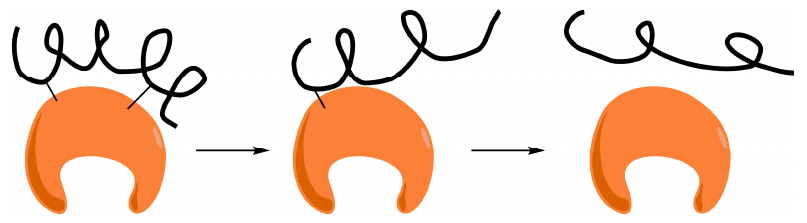
Figure 5. Schematic representation of the interaction process between two amino groups of non-vicinal Lys and two non-vicinal aldehyde groups placed at medium or long distances.